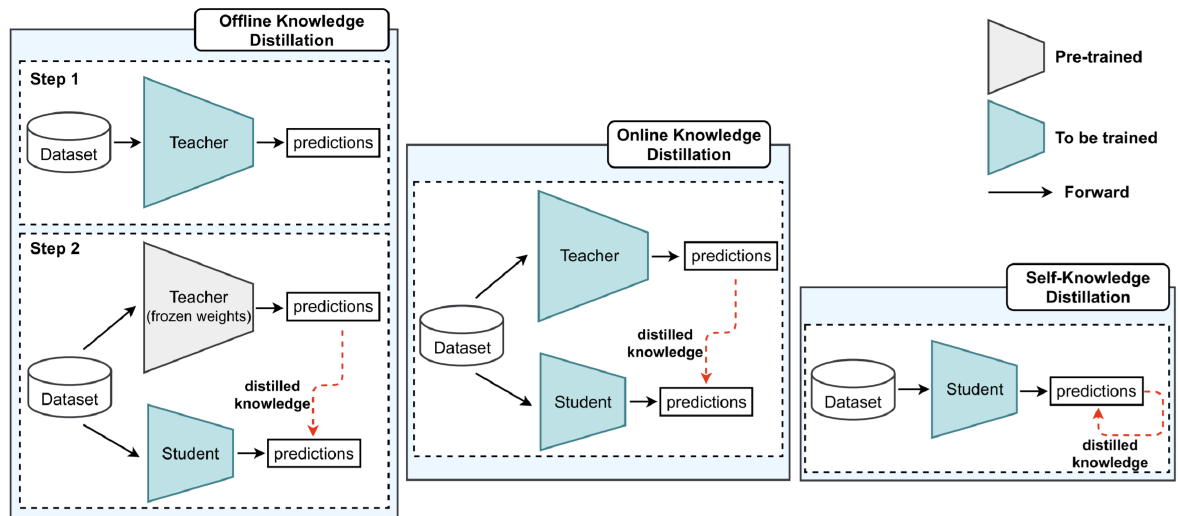
Figure 5. Comparison of different knowledge distillation mechanisms. (Reprinted from ref.